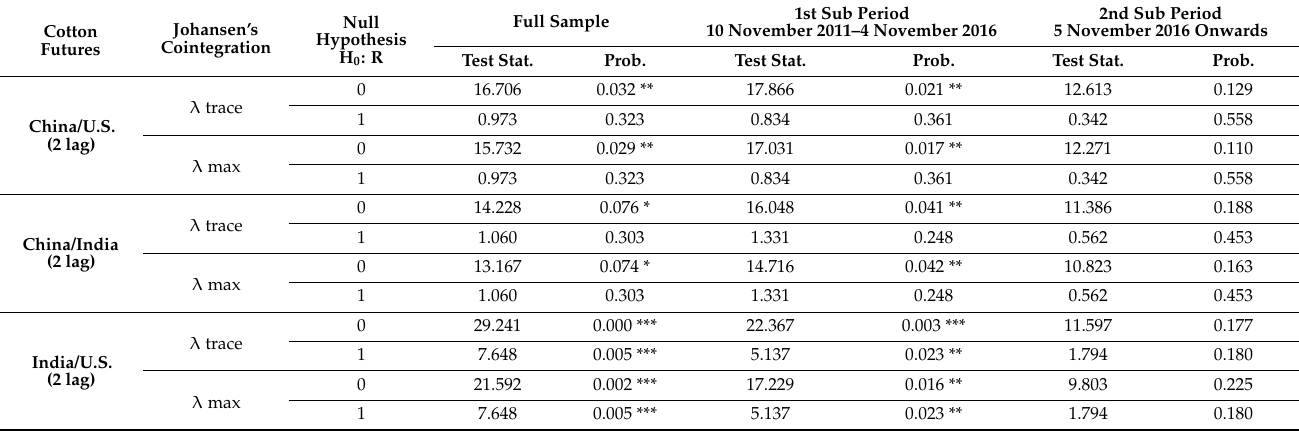
Table 5. Pairwise cointegration